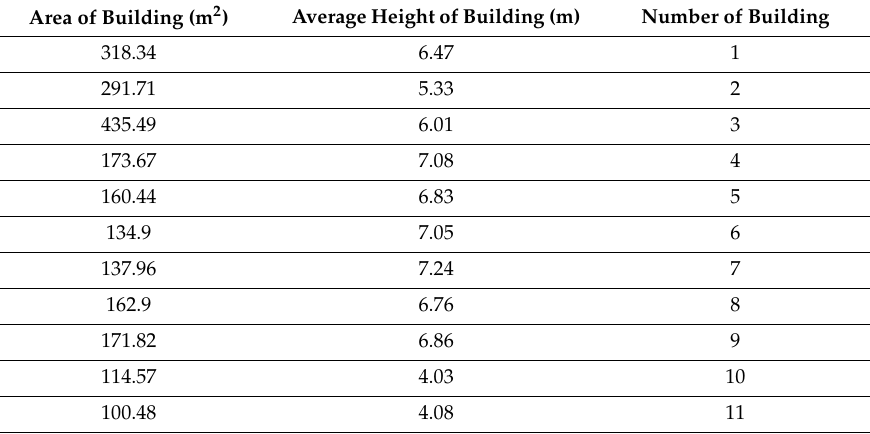
Table 3. The average height and area of each changed